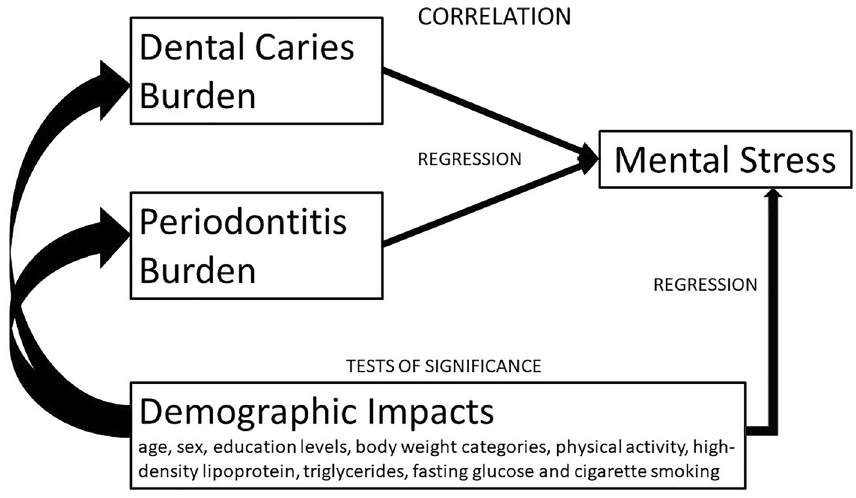
Figure 1. The theoretical framework for the present